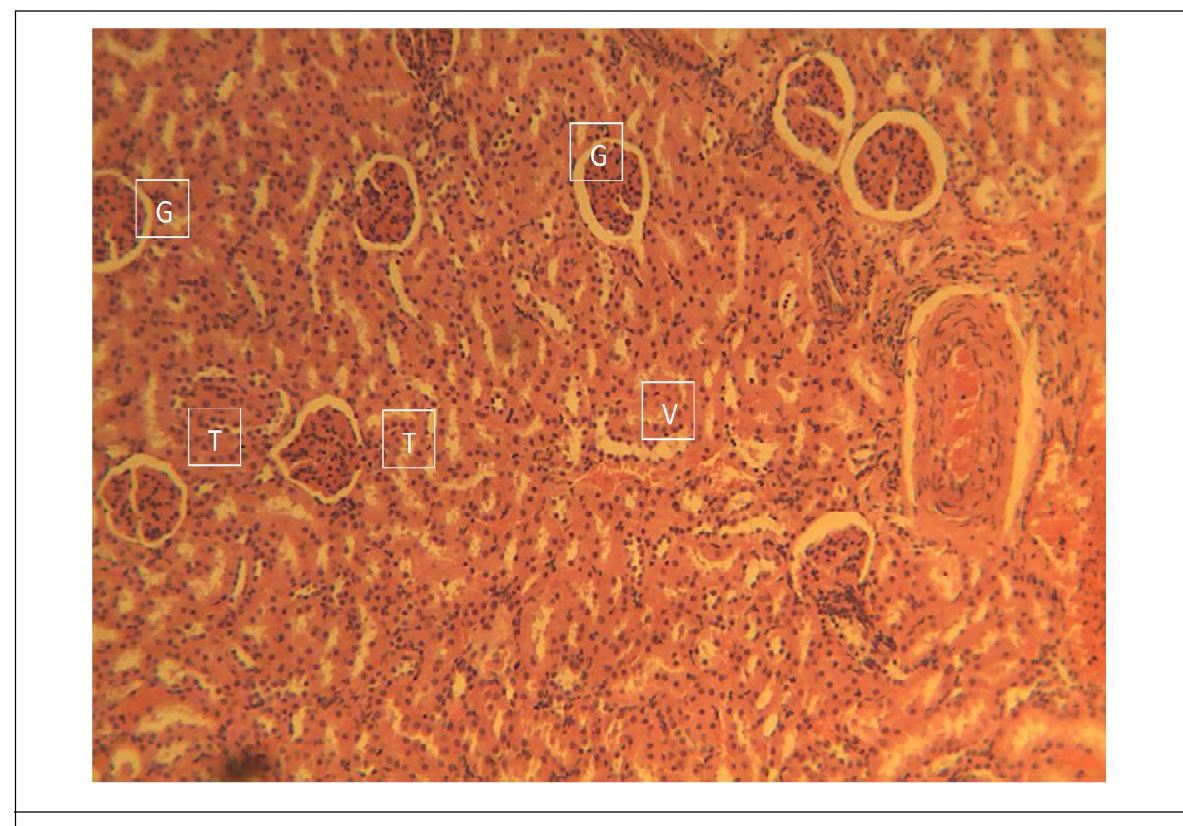
Plate 6: Control group of the male kidney exposed to no extract